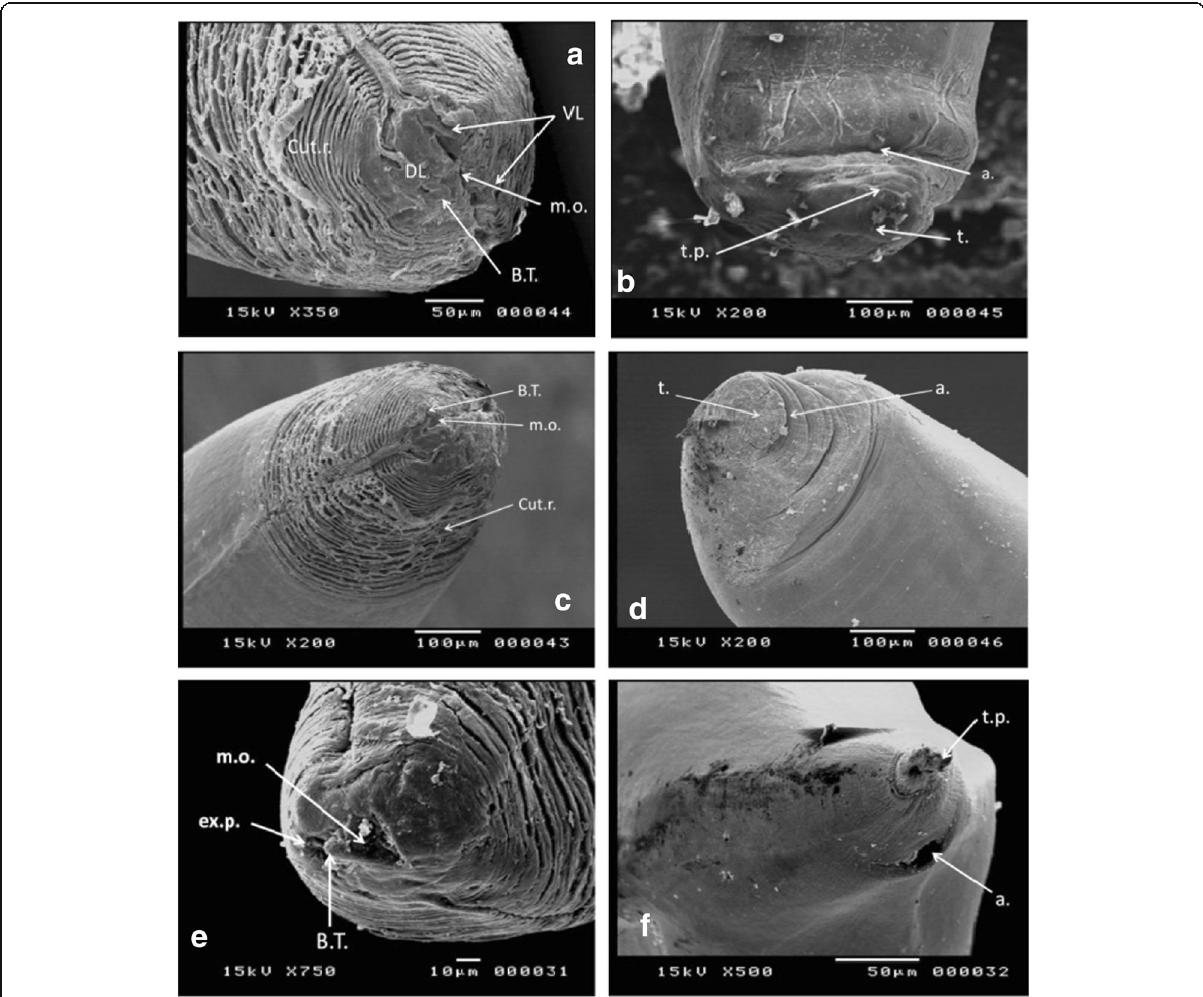
Fig. 2 Scanning electron micrographs: a , b anterior and posterior end of larva collected from Oreochromis niloticus ; c , d anterior and posterior end of larva collected from Tilapia galilae ; e , f anterior and posterior end of short form larva collected from Lates